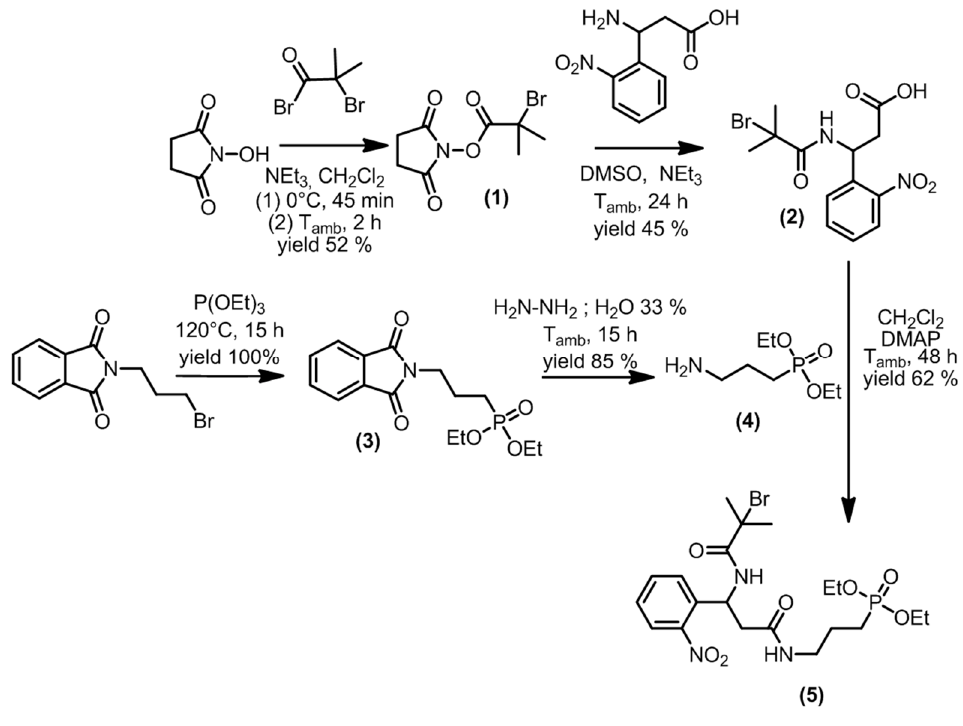
Figure 5. Synthesis procedure of the photocleavable initiator (PCI).